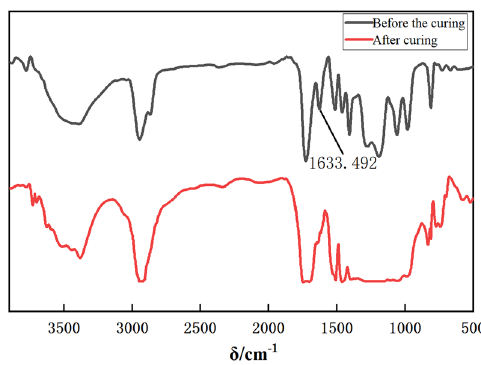
Figure 6: Infrared spectrum of PUA. Figure 7: Infrared spectra before and after curing of the coating.